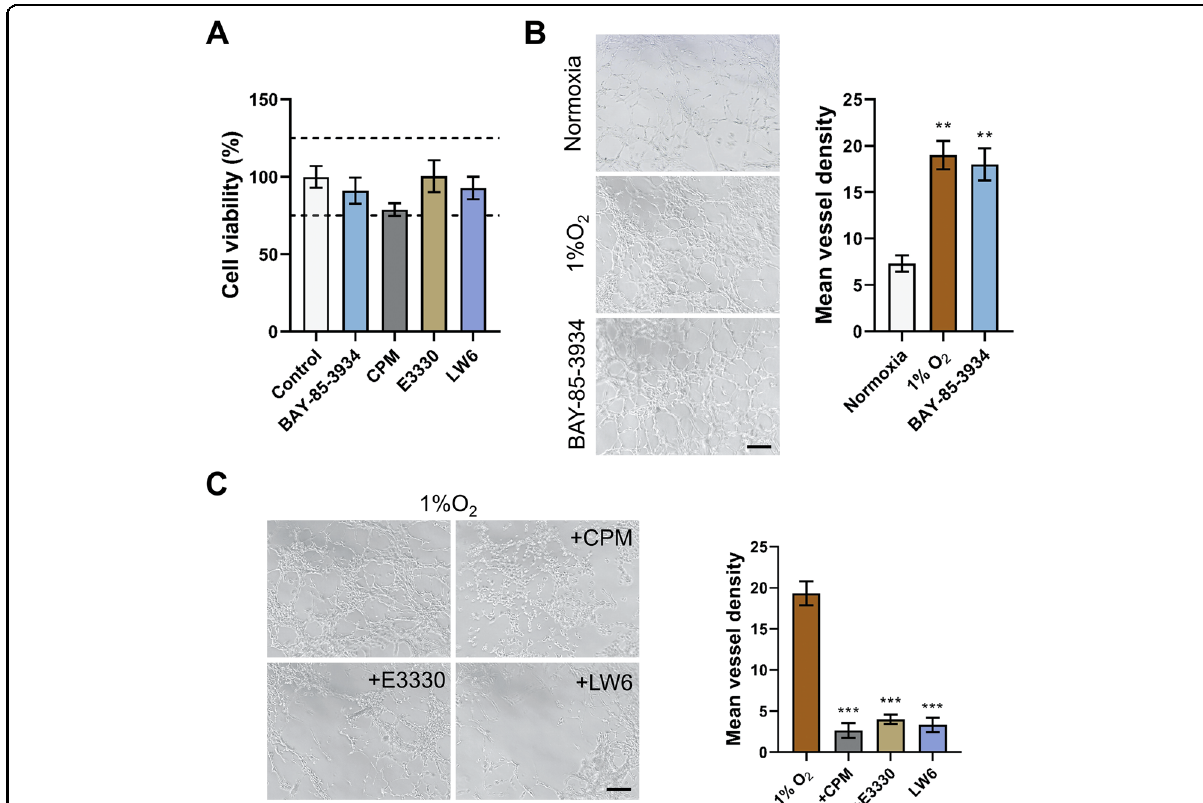
Fig. 6 CPM inhibited the tube formation in HUVECs. A HUVEC cell viability assay by treating with 5 μ M BAY-85-3934, 25 nM CPM, 10 μ M E3330, and 5 μ M LW6. B HUVECs cells were cultured in normoxia and exposed to 1% O 2 and also treated with BAY-85-3934 in 1% O 2 . C One percent O 2 - exposed HUVECs were treated with CPM, E3330, and LW6. Scale bar, 100 μ m. Data were expressed as mean ± SEM ( n = 3). ** P < 0.01, *** P < 0.001 compared to control